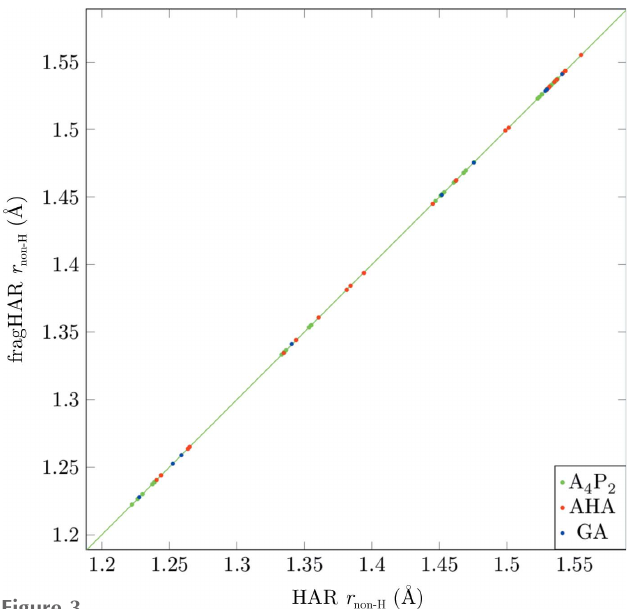
Figure 4 X —H bonds (with error bars) in all model compounds for fragHAR calculations versus reference HAR values. Bonds with notable differ- ences are marked with the corresponding H-atom name.